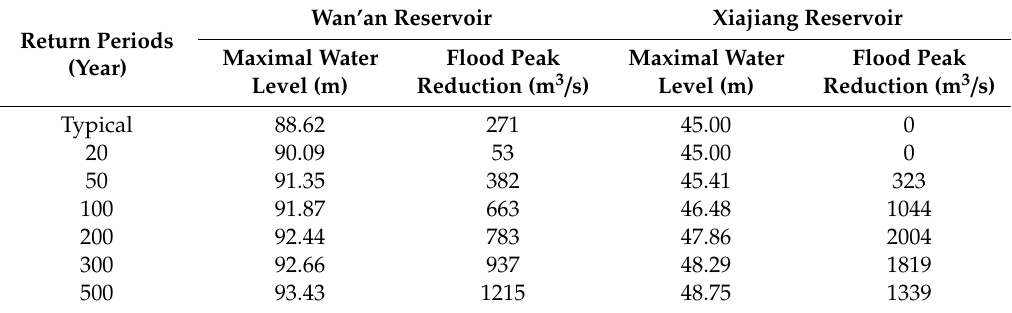
Table 5. Results of Wan’an–Xiajiang cascade reservoirs using conventional flood control operation.